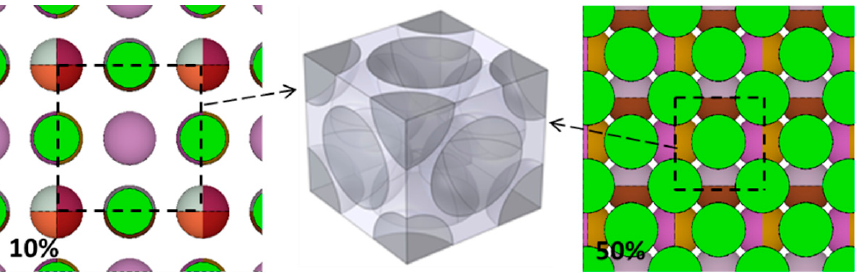
Figure 3. Two-dimensional FCC Model (10 vol.% on the left and 50 vol.% on the right) and three- dimensional FCC Model unit.